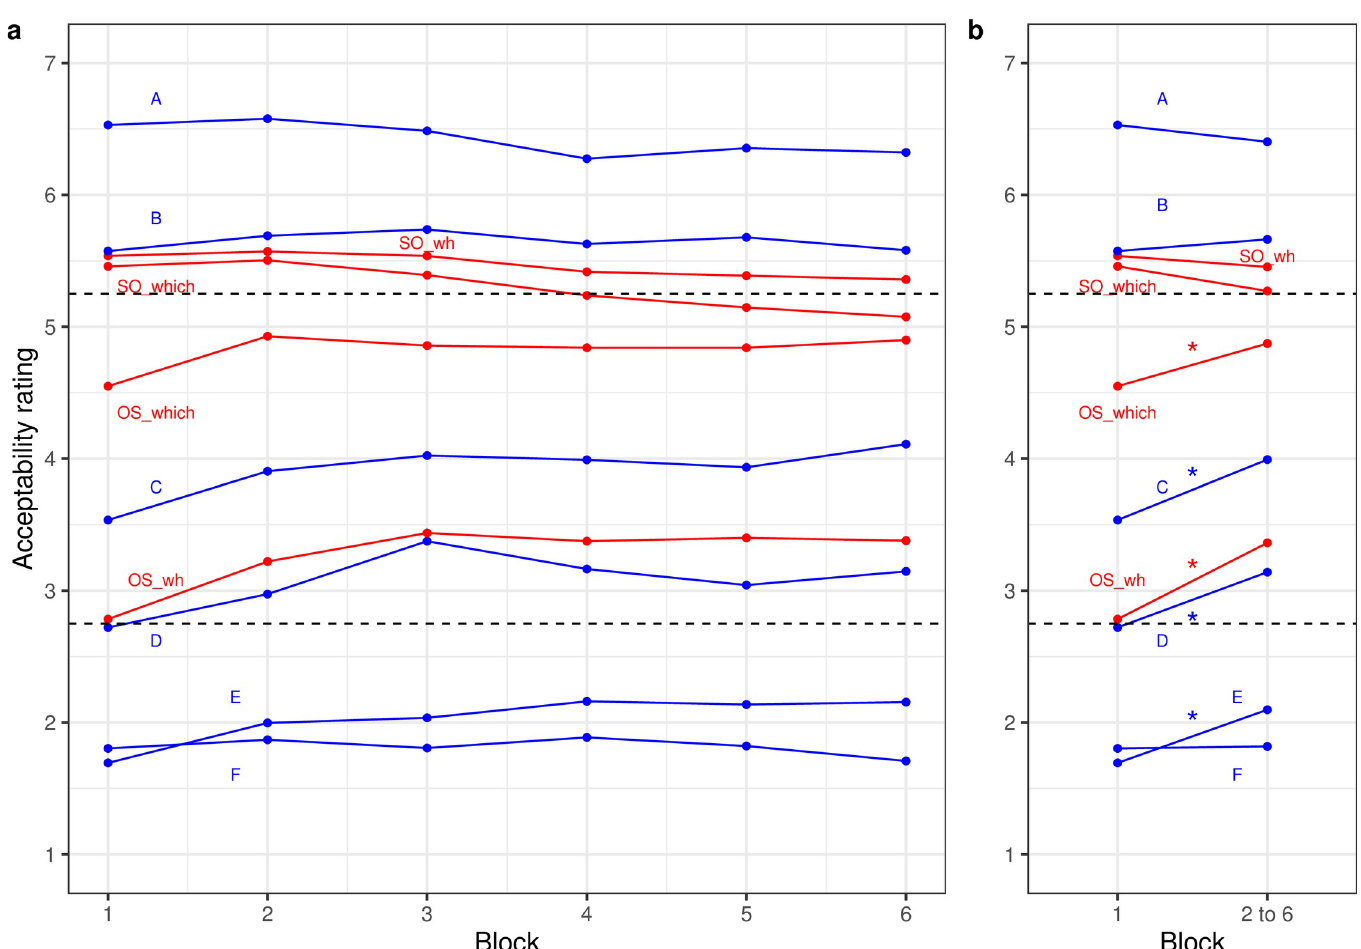
Fig 2. Well-formedness ratings (a) by block and (b) for first block and mean of later blocks for English targets and fillers (web experiment). Dashed lines indicate the upper and lower bounds of the satiation zone based on the 25% criterion. Asterisks indicate significant changes (p <